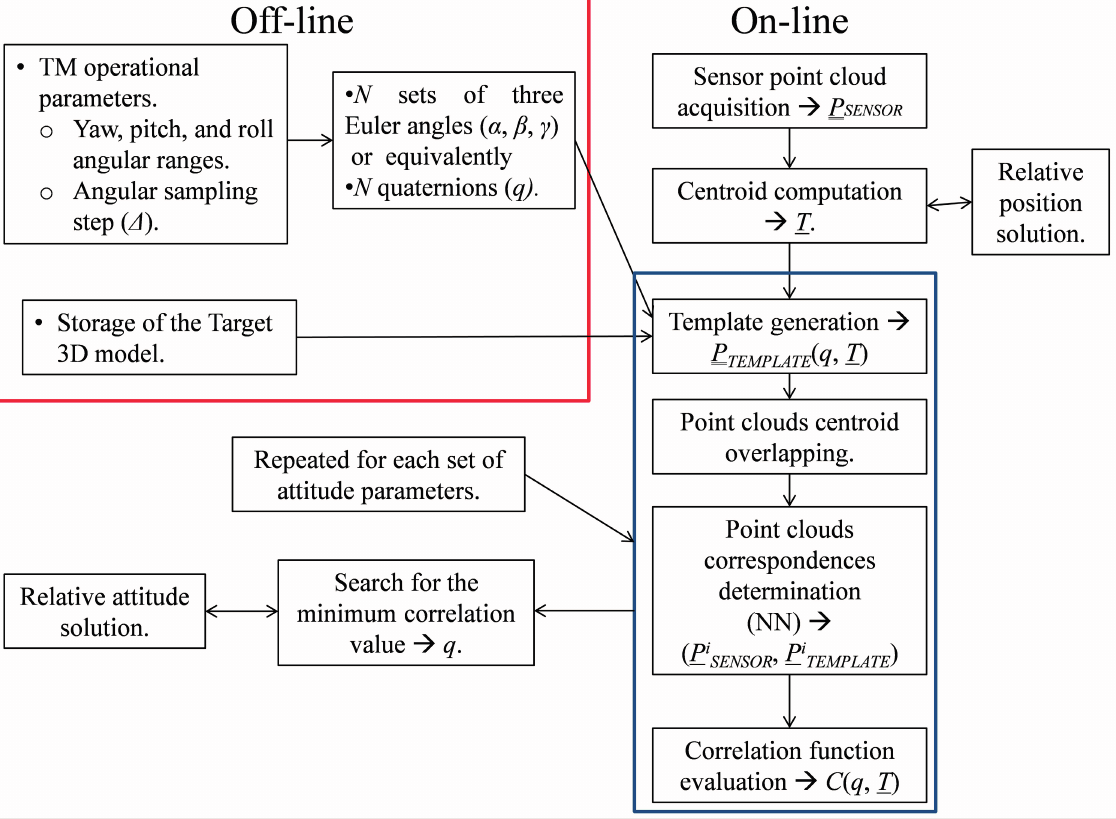
Figure 2. Flow diagram of the on-line TM